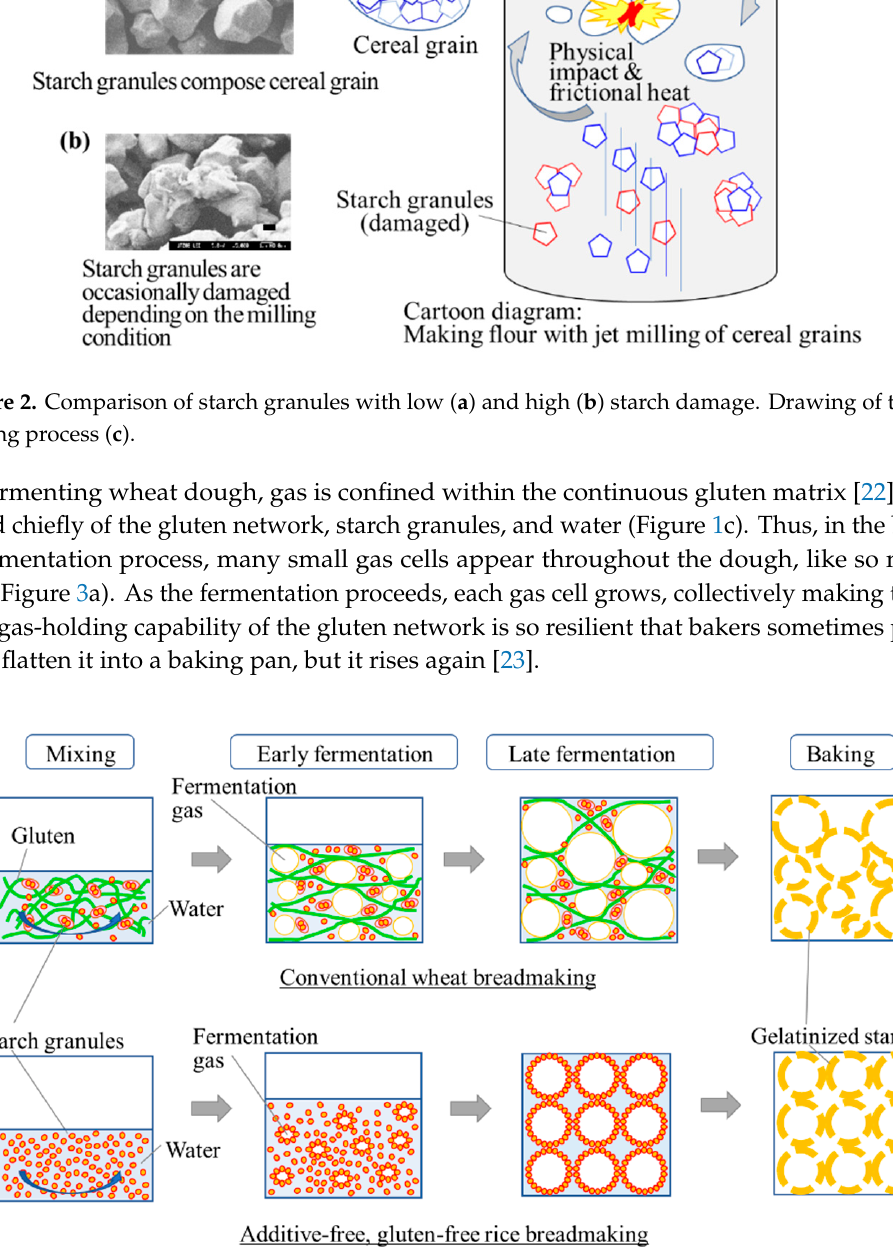
Figure 2. Comparison of starch granules with low ( a ) and high ( b ) starch damage. Drawing of the jet milling process ( c ).